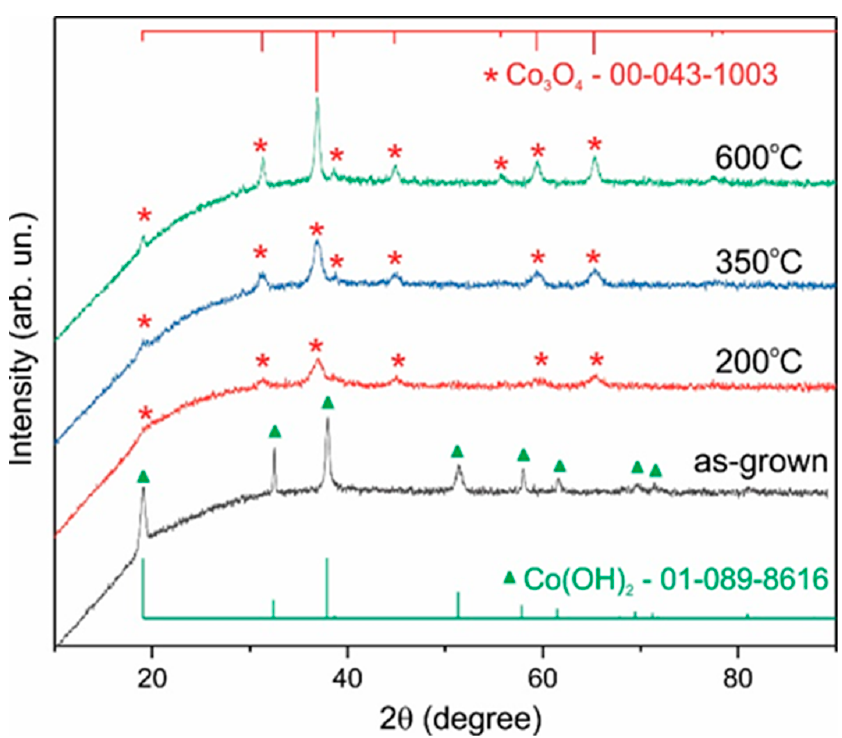
Figure 1. XRD patterns of the as-synthesized Co(OH) 2 sample and Co 3 O 4 samples after annealing in air at temperatures of 200, 350, and 600 °C.